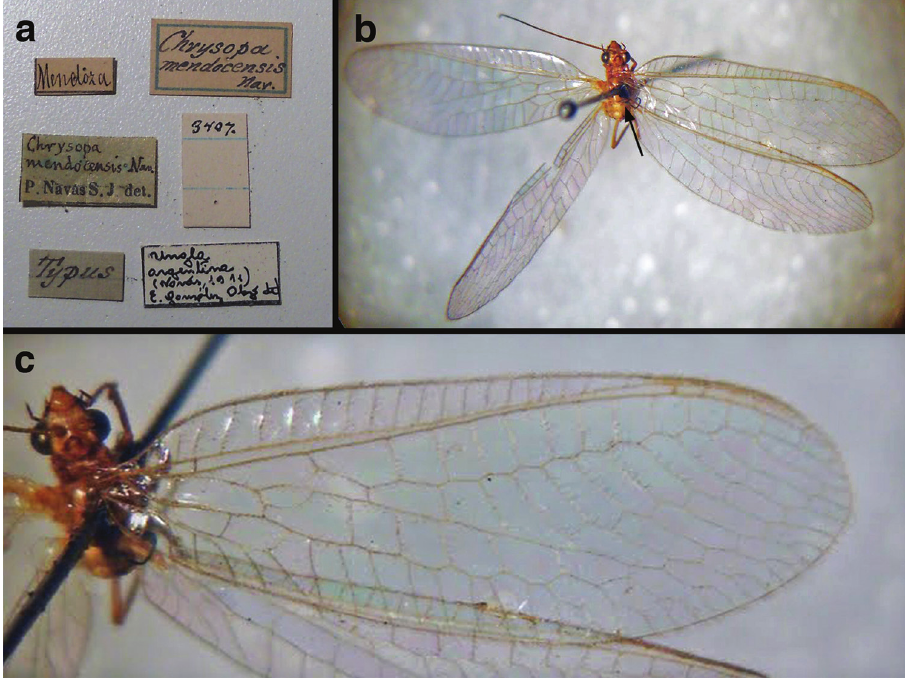
Figure 109. Chrysopa mendocensis Navás: Features, ( a ) labels ( b ) habitus, dorsal, abdomen missing ( c ) forewing (Argentina, Mendoza, lectotype, sex unknown, MLPA).